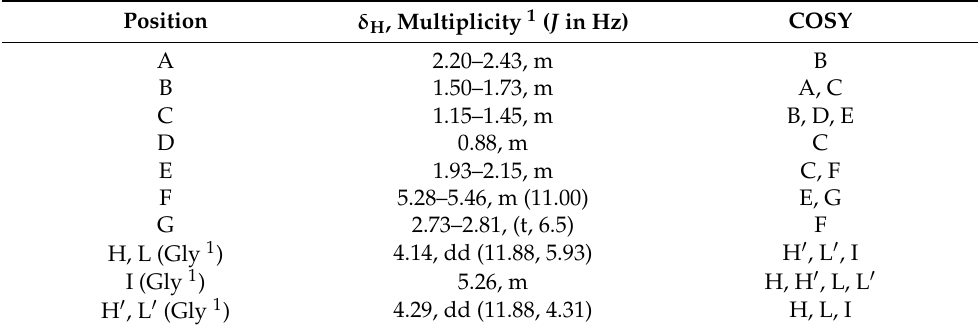
Table 2. 1 H NMR chemical shifts ( δ H , ppm) and 1 H/ 1 H correlations of fatty acid protons in triacyl- glycerols (TAGs) in CDCl 3 for natural CB. The multiplicity of the signal was indicated where possible and the corresponding experimental J -couplings (Hz) were extracted from the spectrum. The letters shown below, which stand for protons belonging to different functional groups of FAs in TAGs, refer to the labelling reported for the first time in Figure 1a.